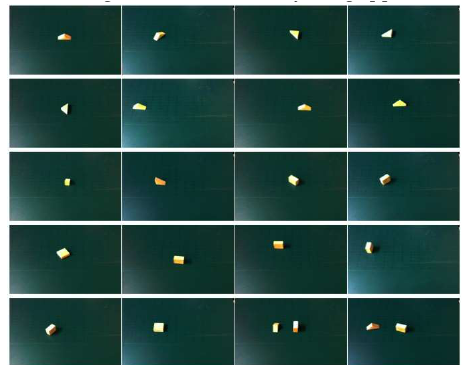
Figure 8. Views from various angles of the object.